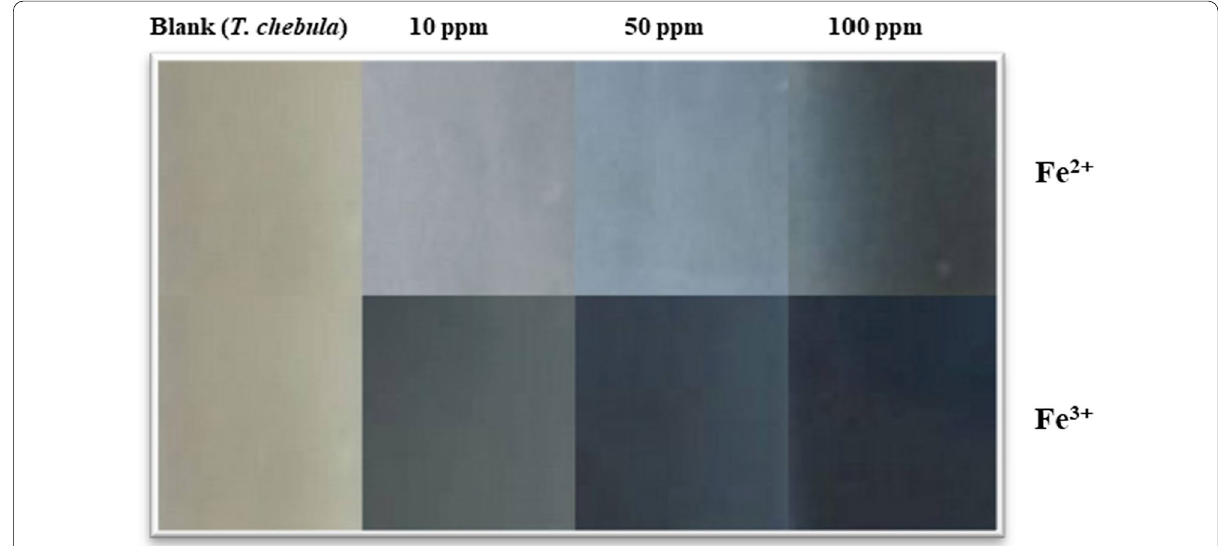
Fig. 5 Colorimetric response of different concentrations of Fe 2 + and Fe 3